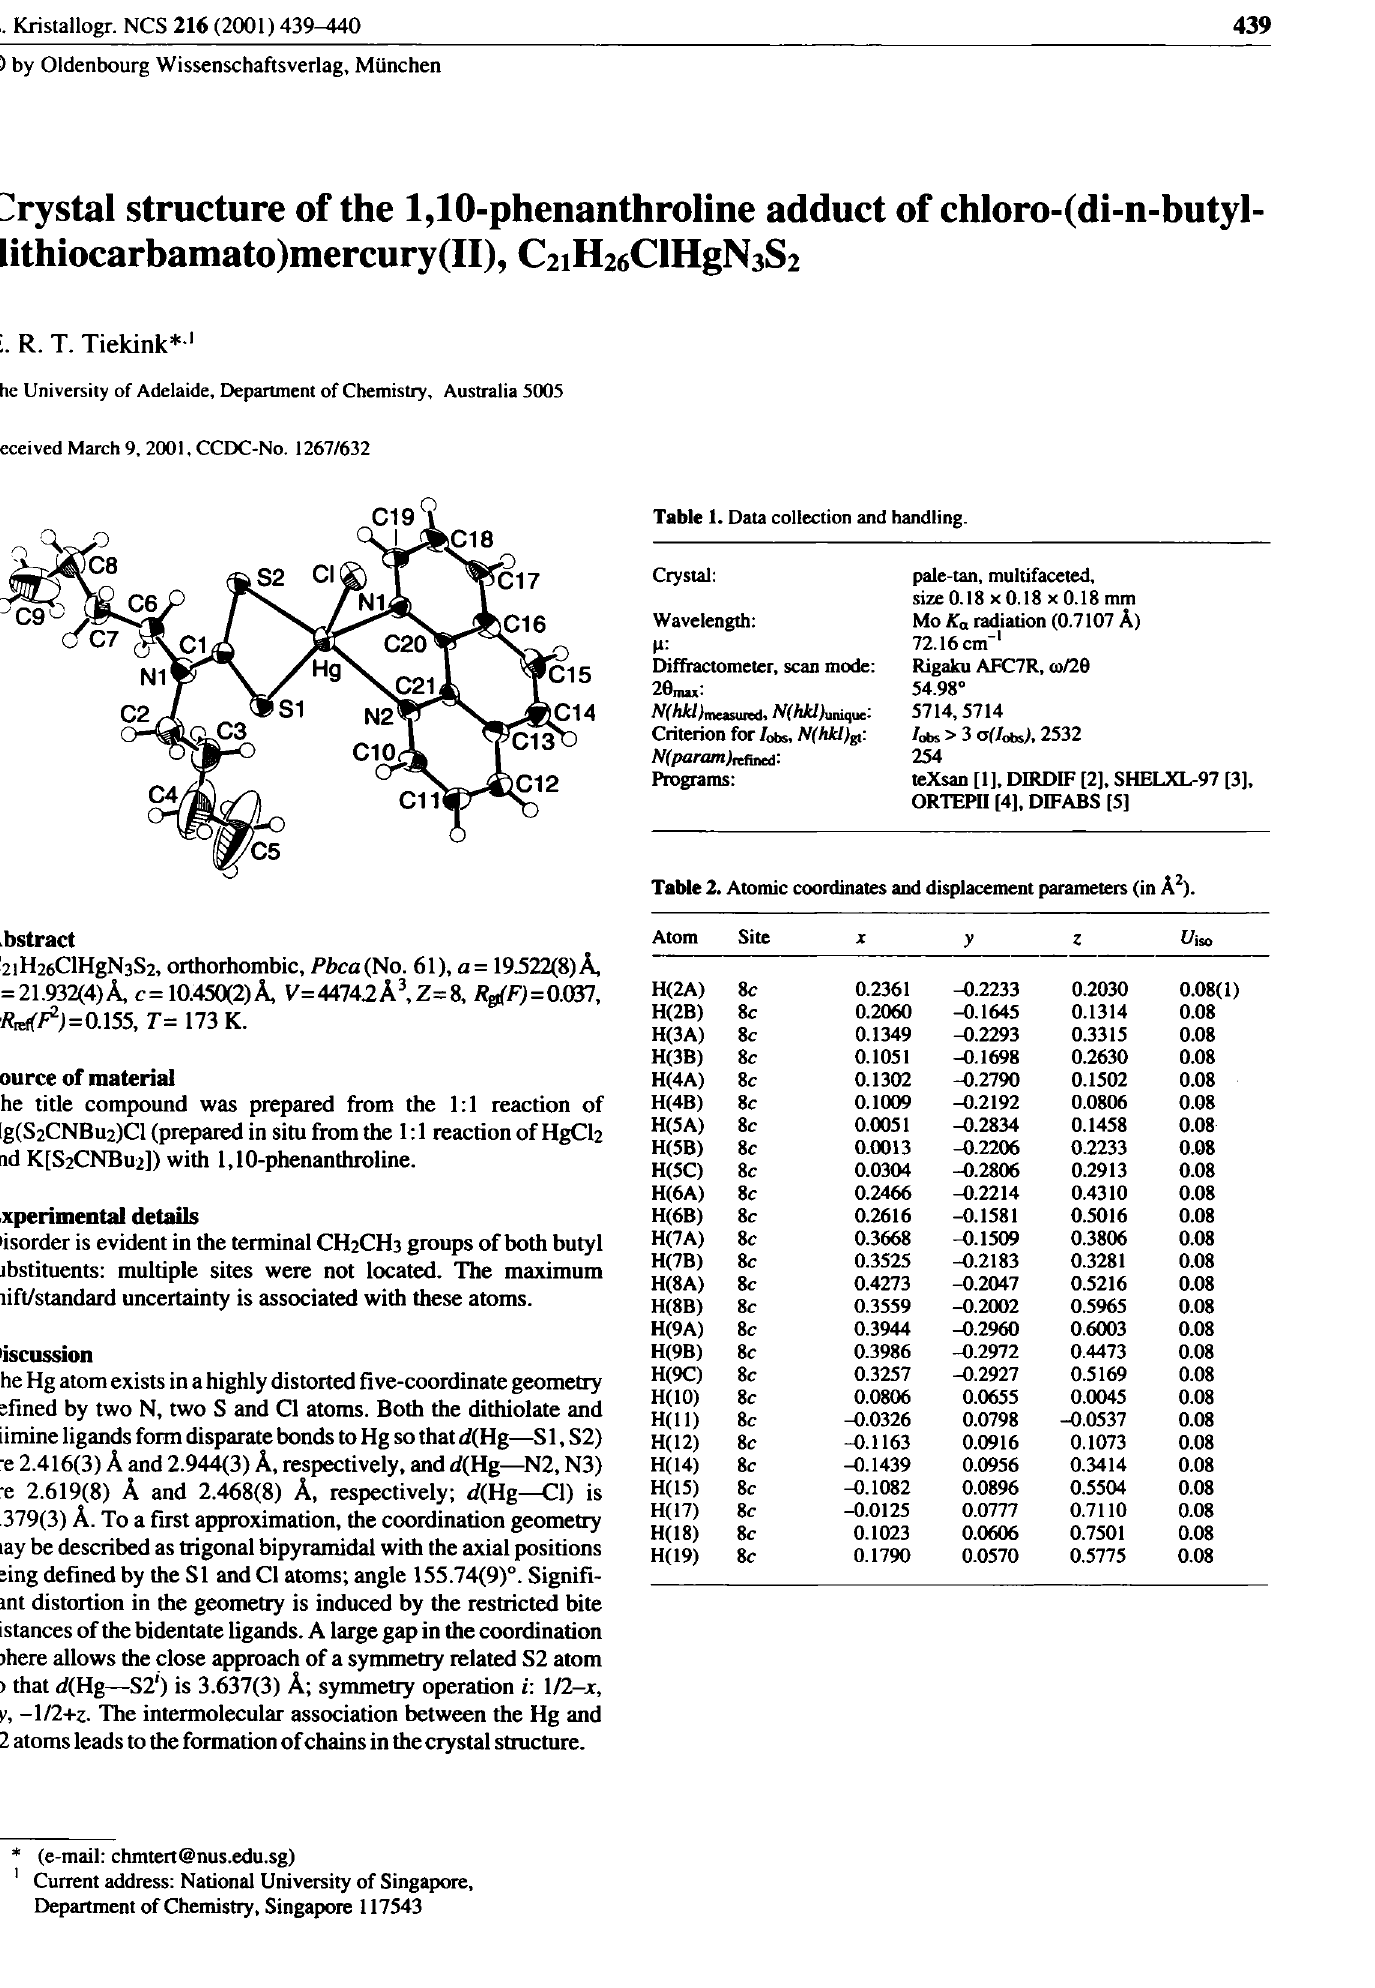
Table 1. Data collection and handling. Crystal: